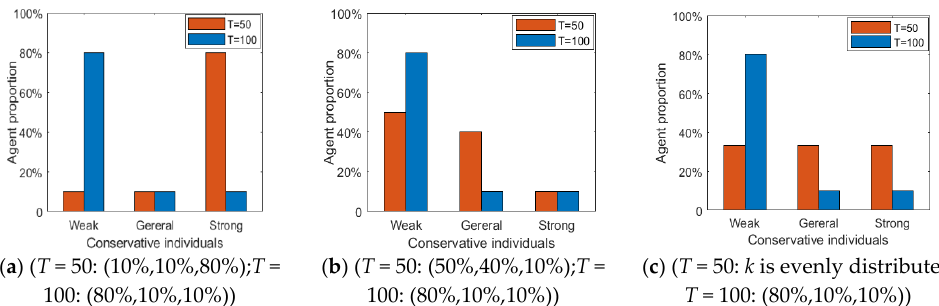
Figure 15. Distribution histogram of three kinds of individuals with different conservation at different times. ( a ) ( T = 50: (10%,10%,80%); T = 100:(80%,10%,10%));( b ) ( T = 50: (50%,40%,10%); T =